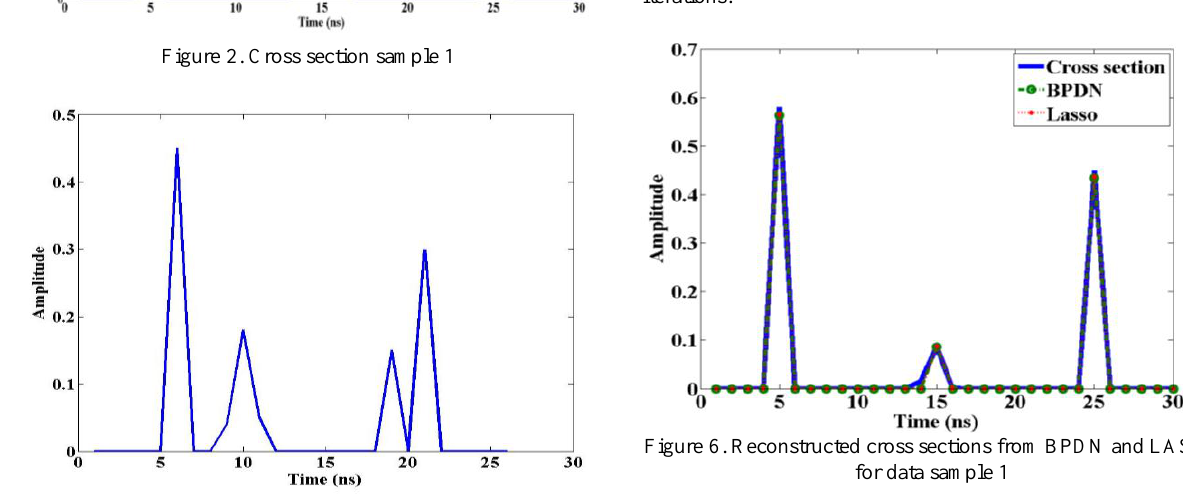
Figure 3. Cross section sample 2